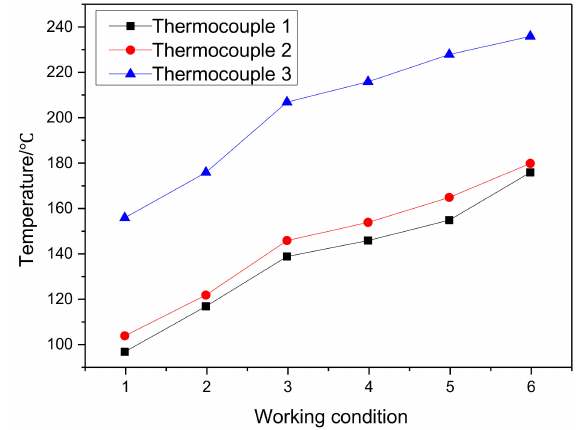
Figure 14. Thermocouple temperature under different working conditions (Working conditions 1–3: flue gas temperature, 1000 ◦ C, 1100 ◦ C, and 1200 ◦ C, respectively; cooling water flow rate, 16 t/h. Working conditions 4–6: flue gas temperature, 1200 ◦ C; cooling water flow, 12 t/h, 8 t/h, and 4 t/h, respectively. Thermocouples 1–3: thermocouple temperature of 10 mm from the hot surface at the upper, middle and lower parts of copper